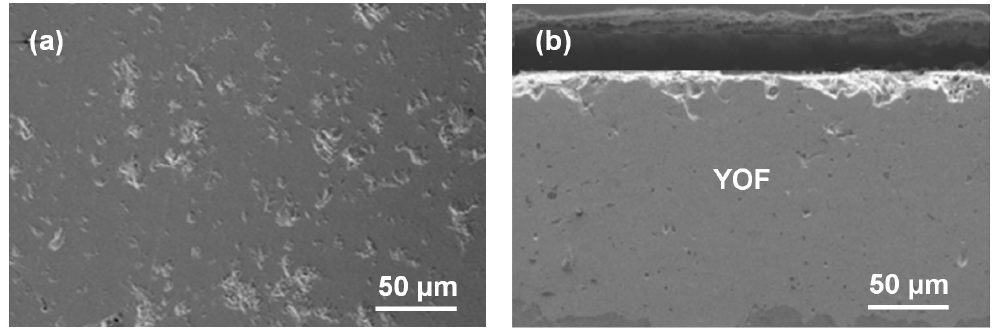
Figure 1. Surface ( a ) and cross-sectional SEM images ( b ) of yttrium oxyfluoride (YOF) coated at a plasma spray power of 15 kW.